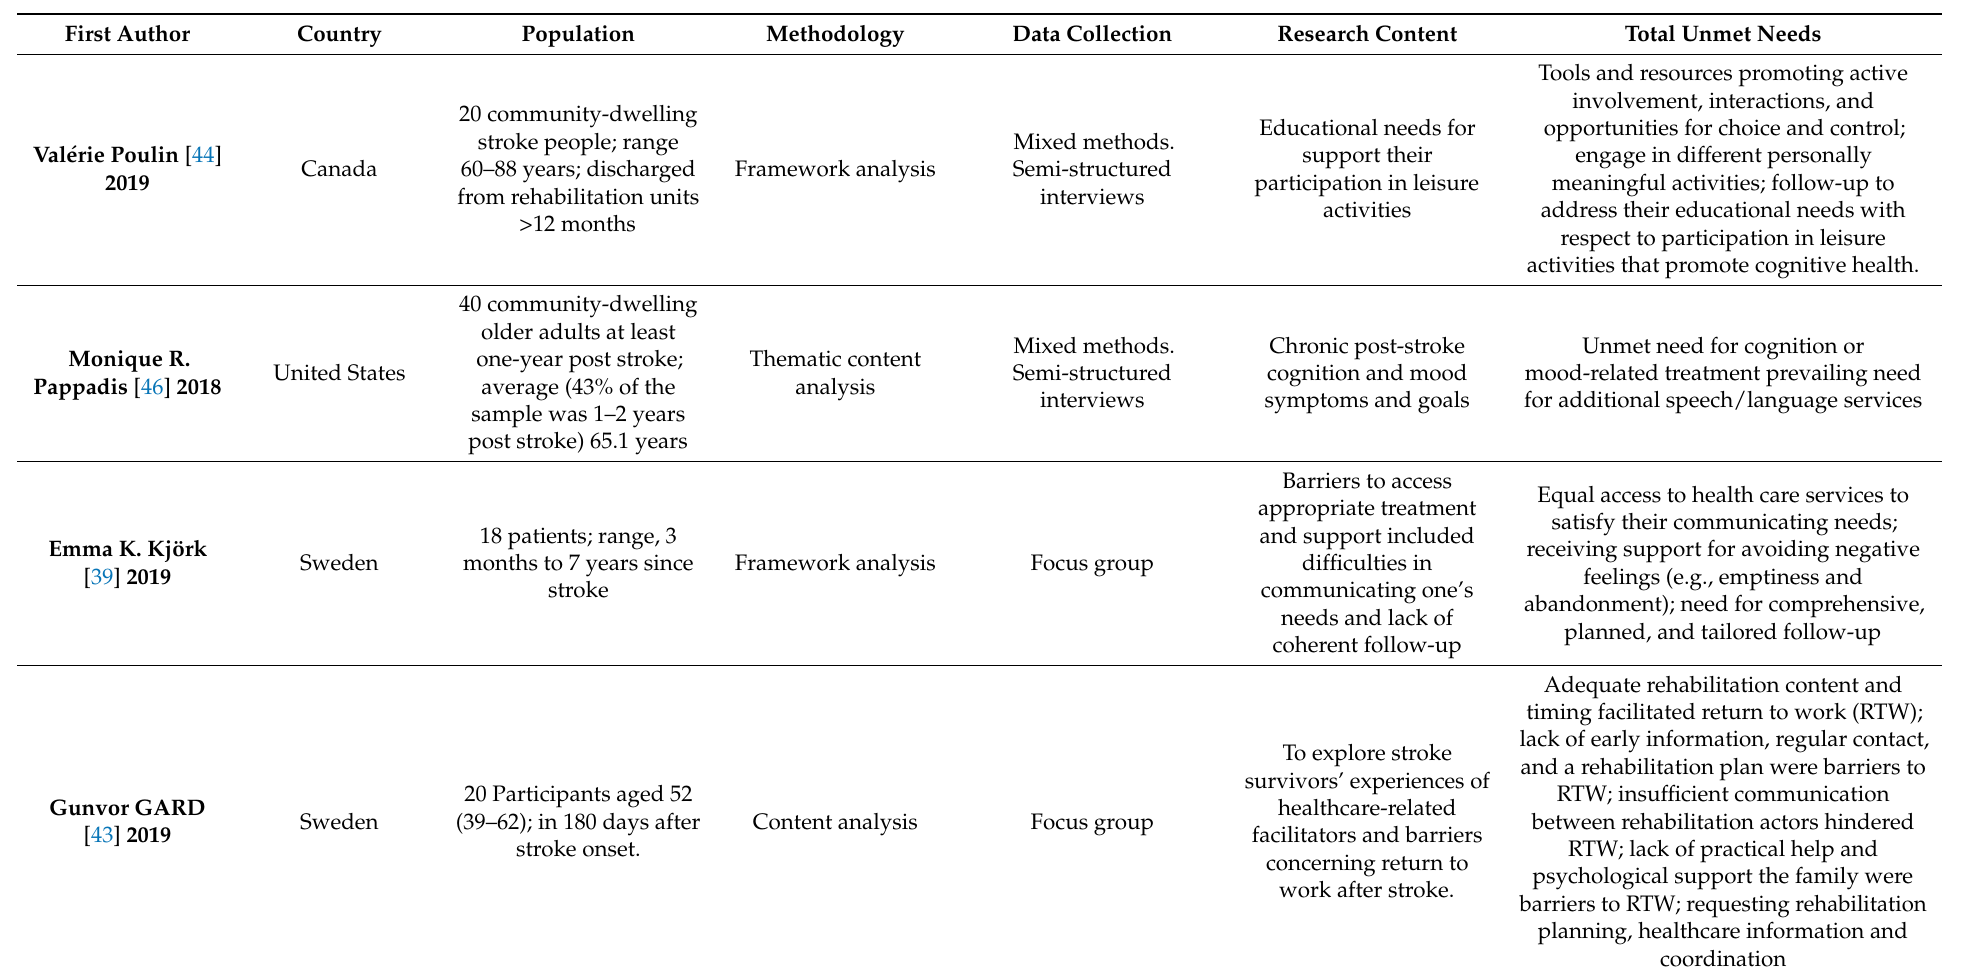
Table 1. Characteristics of studies involved ( n =